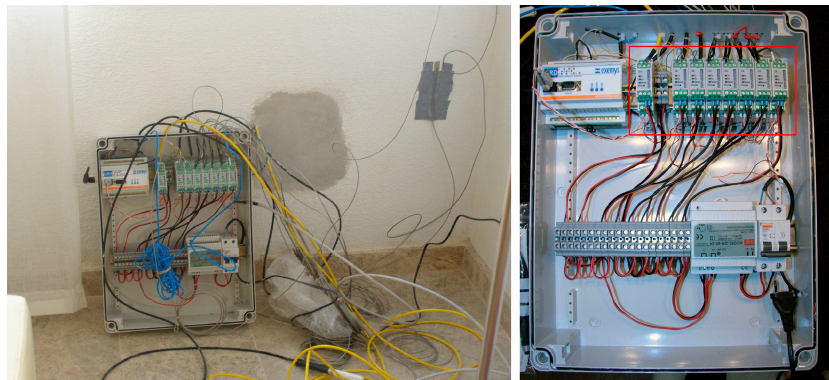
Figure 11. Data Logger, Data Reception and GPRS Communication.